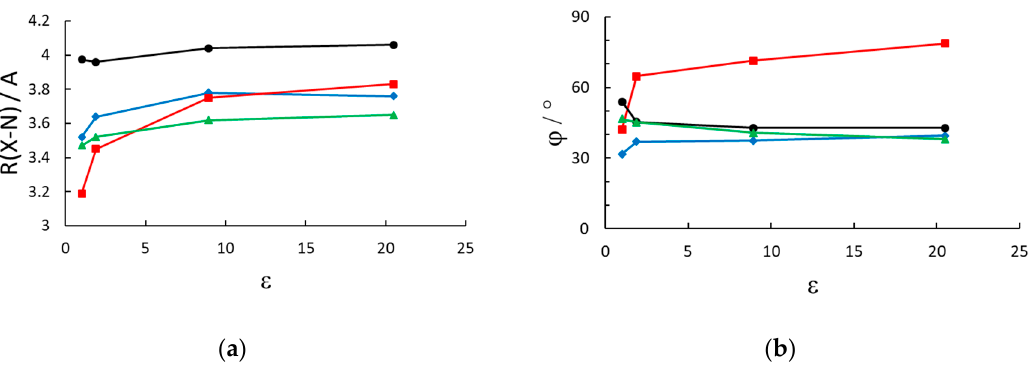
Figure 2. Geometrical parameters of the energy minimized structures vs. the dielectric constants of the solvent (vacuum, n -hexane, dichloromethane, acetone). ( a ) Average distance between each pyridinium nitrogen and the closest anion’s center of mass and ( b ) dihedral angle between the two pyridinium rings. (black circles): MV(PF 6 ) 2 ; (red squares): MVBr 2 ; (green triangles): MTMVI 2 ; (blue rhombi): MVI 2 .